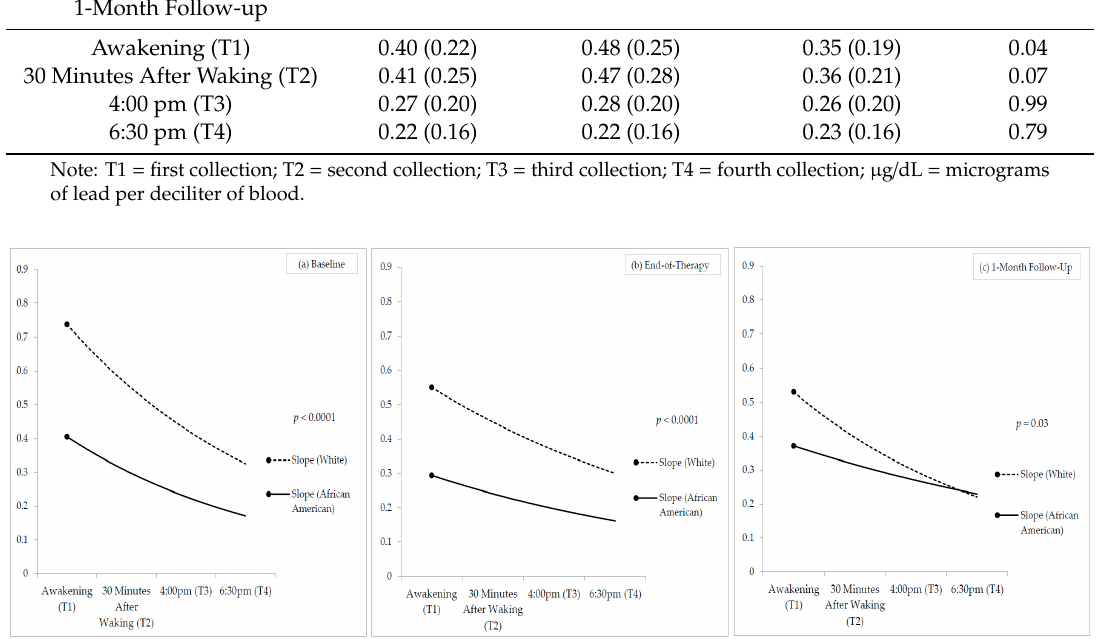
Figure 1. Cortisol Concentrations by Race/Ethnicity